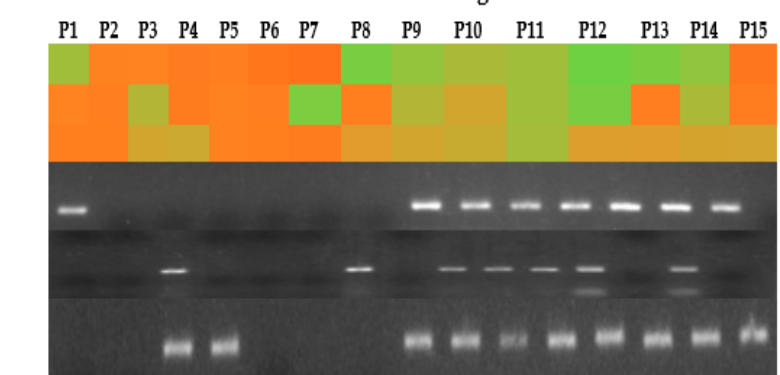
Figure 4. TPD1-like gene amplification in leaves using date palm seedling cDNA as template. PCR product was run on 1.5% agarose gel, using a 100 bp ladder (Thermo Scientific Inc., Waltham, MA, USA). The heat map indicated the expression intensity: green for higher expression, light green for low expression and orange for no expression.